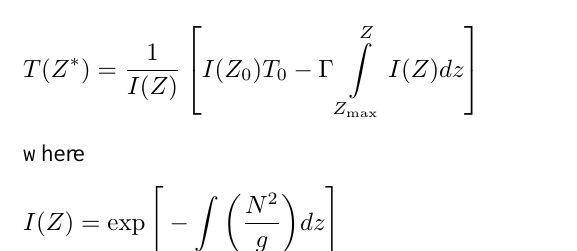
altitude Z is estimated